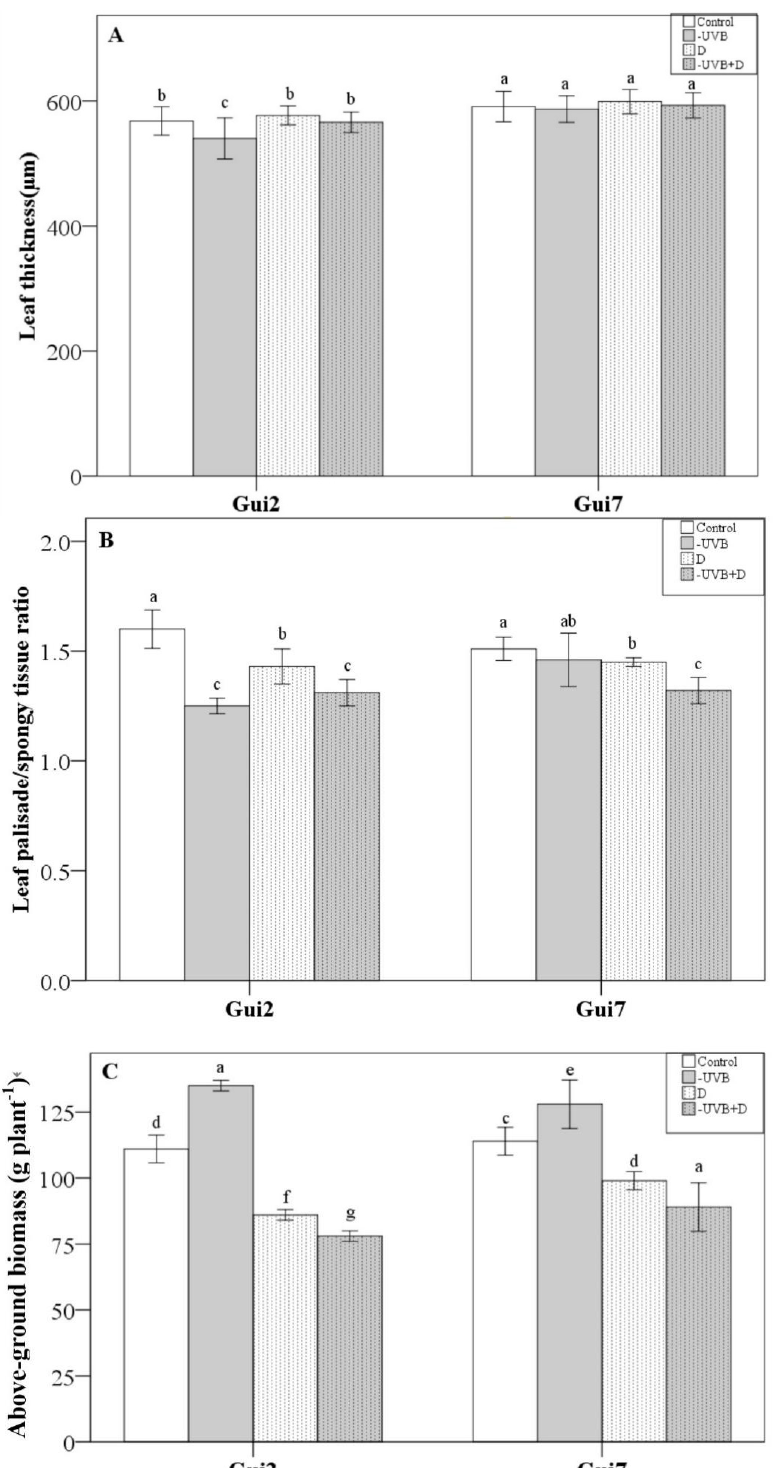
Figure 1. Leaf thickness ( A ), leaf palisade/spongy tissue ratio ( B ) and plant above-ground biomass ( C ) of two Chestnut rose cultivars under different water regimes and solar UV-B treatments. Values are mean ± SD. Different letters above the bars indicate a significant difference between treatments at p < 0.05 level by LSD pairwise comparisons. Control, ambient UV-B; –UV-B, UV-B exclusion; D, drought with ambient UV-B; –UV-B+D, drought with UV-B